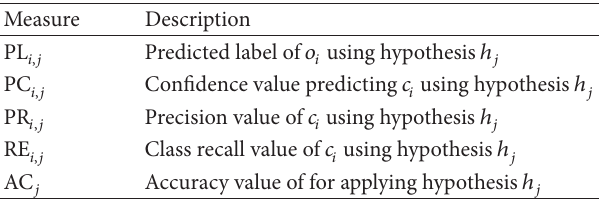
Table 1: Classifier’s performance measurements.